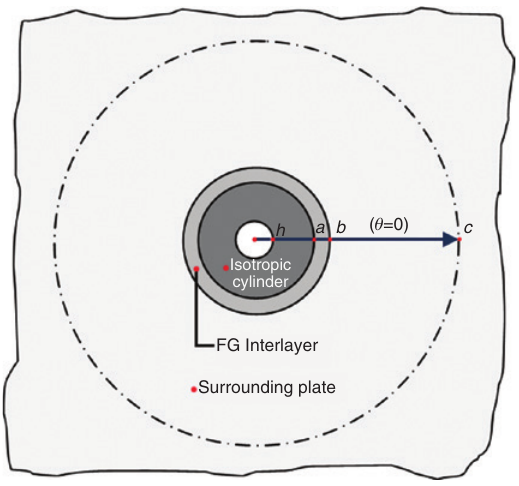
Figure 2: Geometry and parametric dimension of the joint in the presence of FG